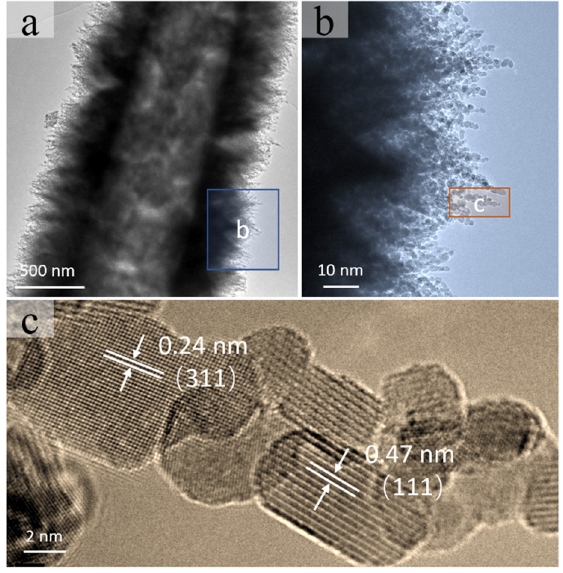
Figure 4. ( a , b ) TEM image of CuCo 2 O 4 @CNFs, ( c ) HRTEM images of the CuCo 2 O 4 @CNFs.